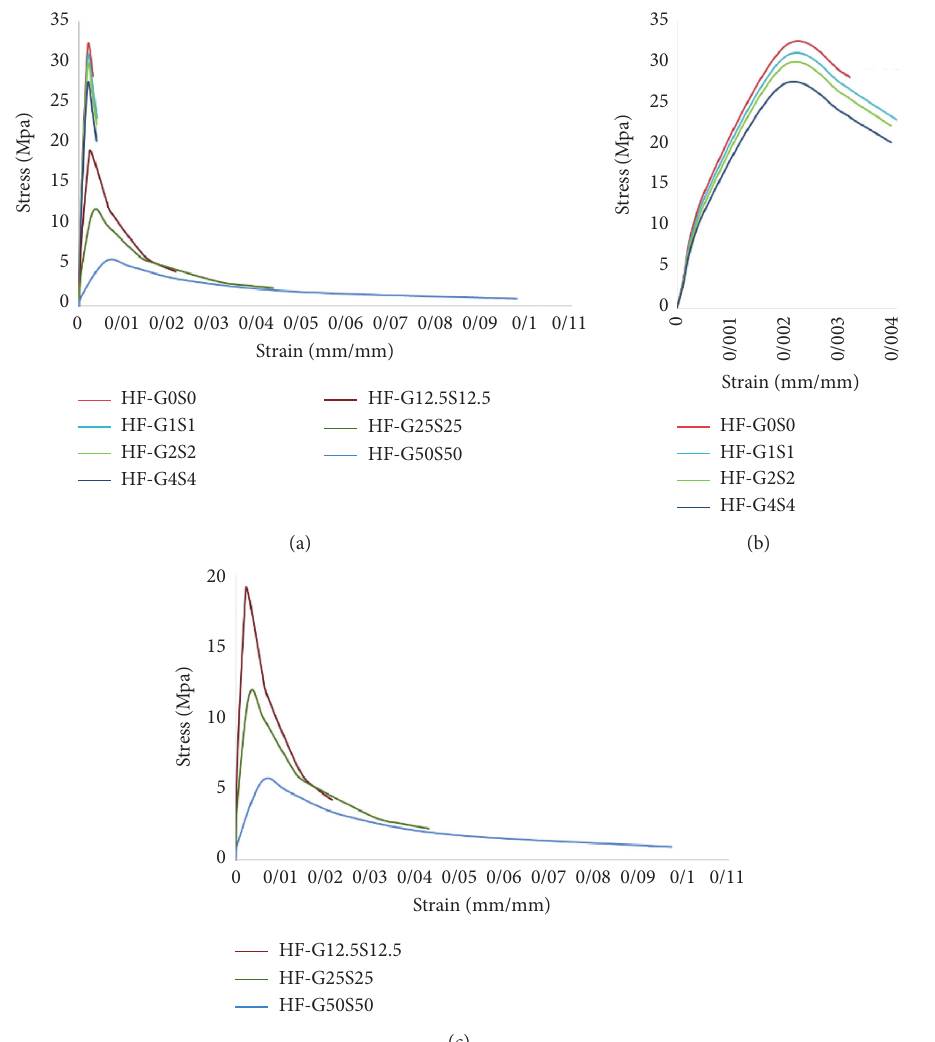
Figure 6: Stress-strain curve of LF specimens at 28 days. (a) Stress-strain diagrams of all LF specimens at 28 days. (b) Stress-strain diagrams of LF specimens with low content of silicone rubber at 28 days. (c) Stress-strain diagrams of LF specimens with a high content of silicone rubber at 28